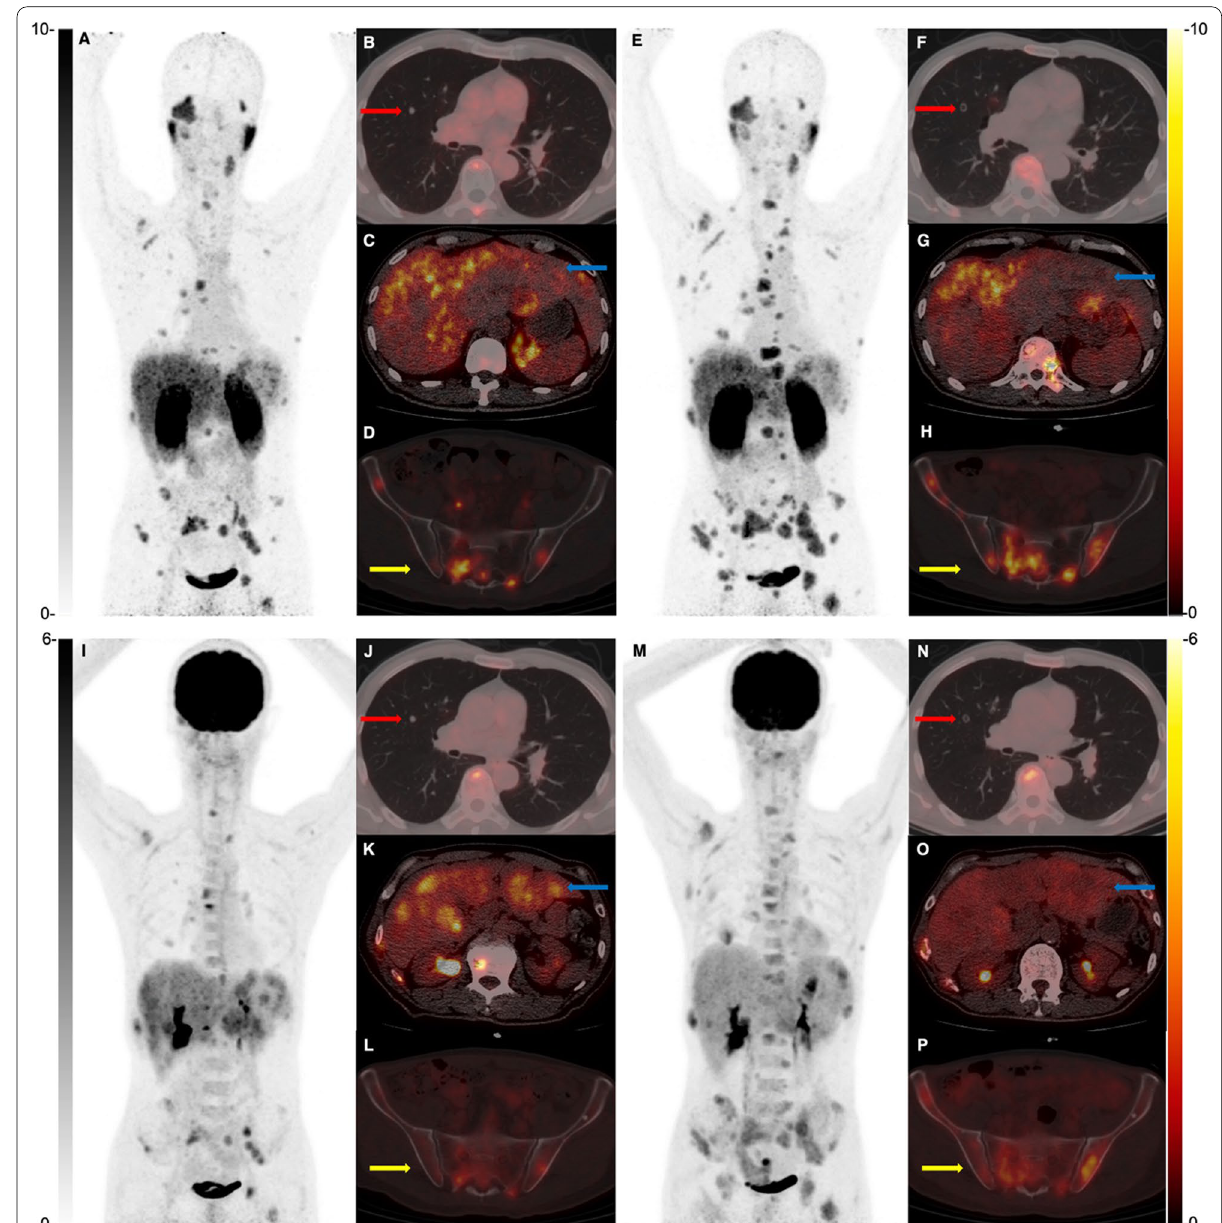
Fig. 6 A 56-year-old male patient was diagnosed with local recurrence and multiple metastases 12 months after surgical removal of nasal ACC. Pre-therapy 68 Ga-PSMA-617 ( A – D ) and 18 F-FDG PET/CT ( I – L ) depicted neoplasm recurrence, multiple liver, bone, and lung metastases. 68 Ga-PSMA-617 PET/CT ( E – H ) and 18 F-FDG PET/CT ( M – P ) reexamination at 8 weeks after the 1st cycle of PSMA RLT revealed the decreased SUVmax of lung metastases (red arrow) and liver metastases (blue arrow); and CT showed liquefied necrosis occurred inside the lung nodule (red arrow). The uptakes of bone metastases (yellow arrow), however, were significantly